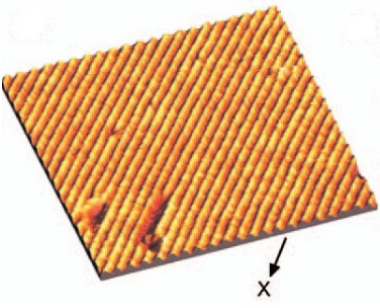
Figure 1. The scanning tunneling microscopy images of cleaved In 4 Se 3 . Reproduced with